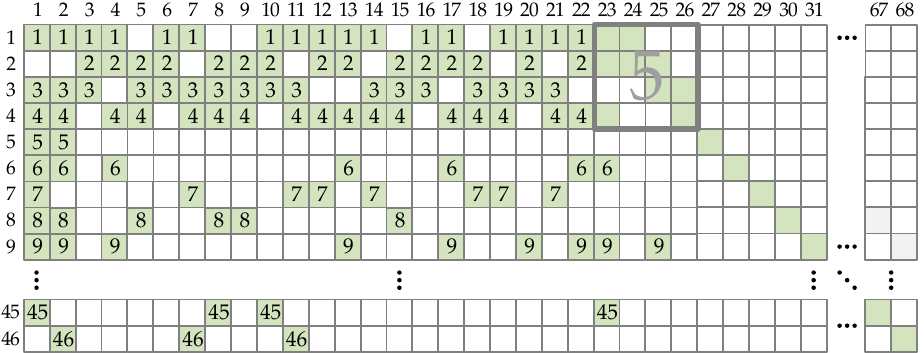
Figure 3. Encoding schedule for BG1 codes when processing the entire base graph matrix column at the same time. Numbers represent the ordinal of the clock cycle in which the corresponding CPM is processed.